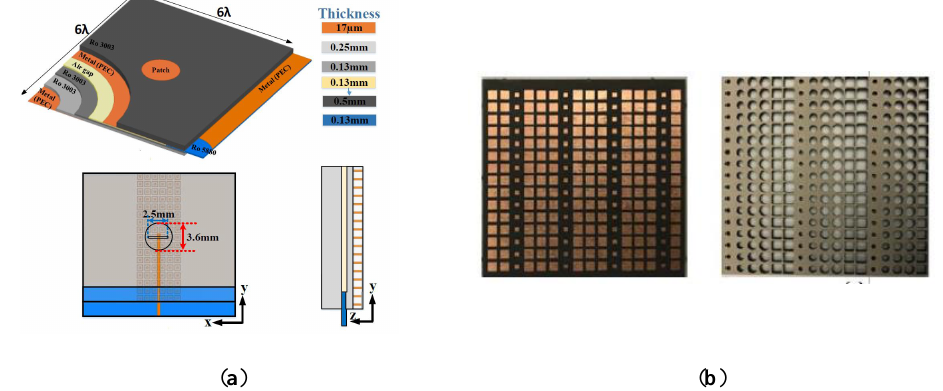
Figure 16. Configuration of a RCA with a tilted beam: ( a ) Main radiating element (PRGW); ( b ) Fabricated prototype of PGS and PDGS [139].